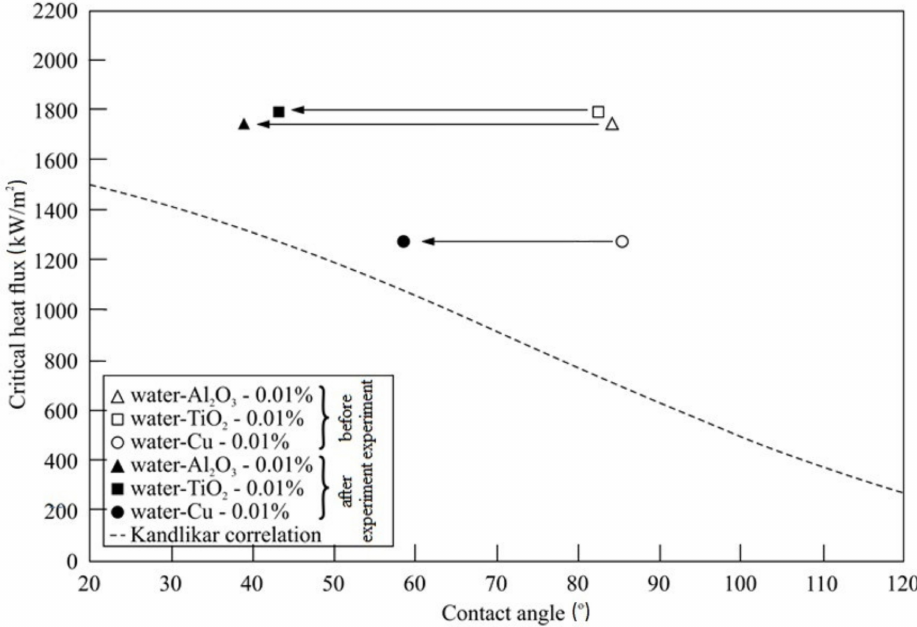
Figure 11. CHF against contact angle ( D o = 1.6